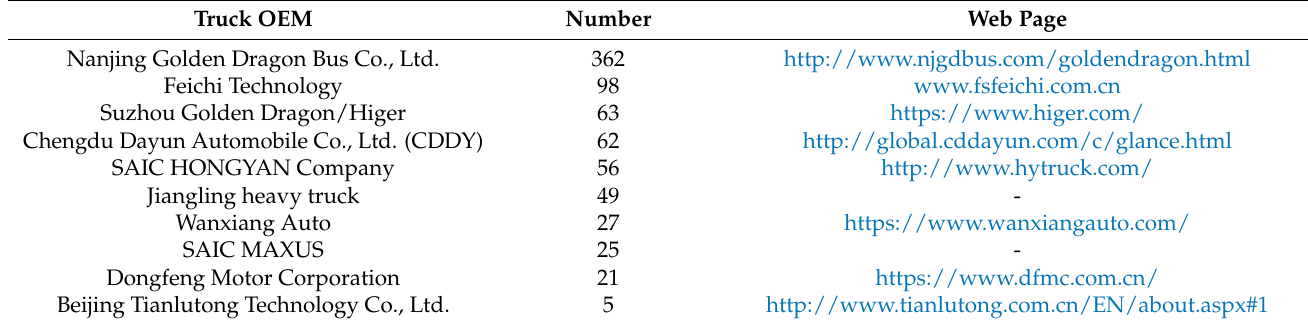
Figure 6. Waterfall diagram showing the breakdown of HD FCTs worldwide. Table 2. Distribution of heavy-duty fuel cell trucks in China to different OEMs [31] .